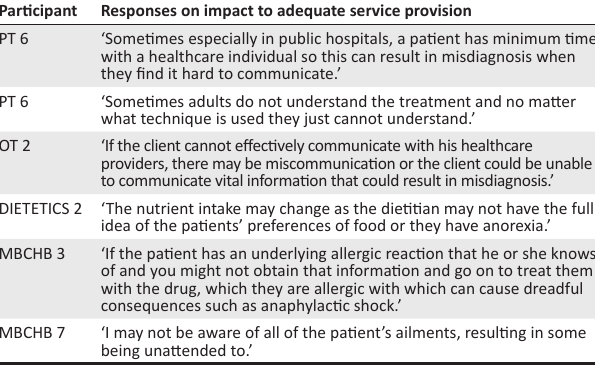
TABLE 4: Participants’ responses on the impact of communication difficulties on adequate service